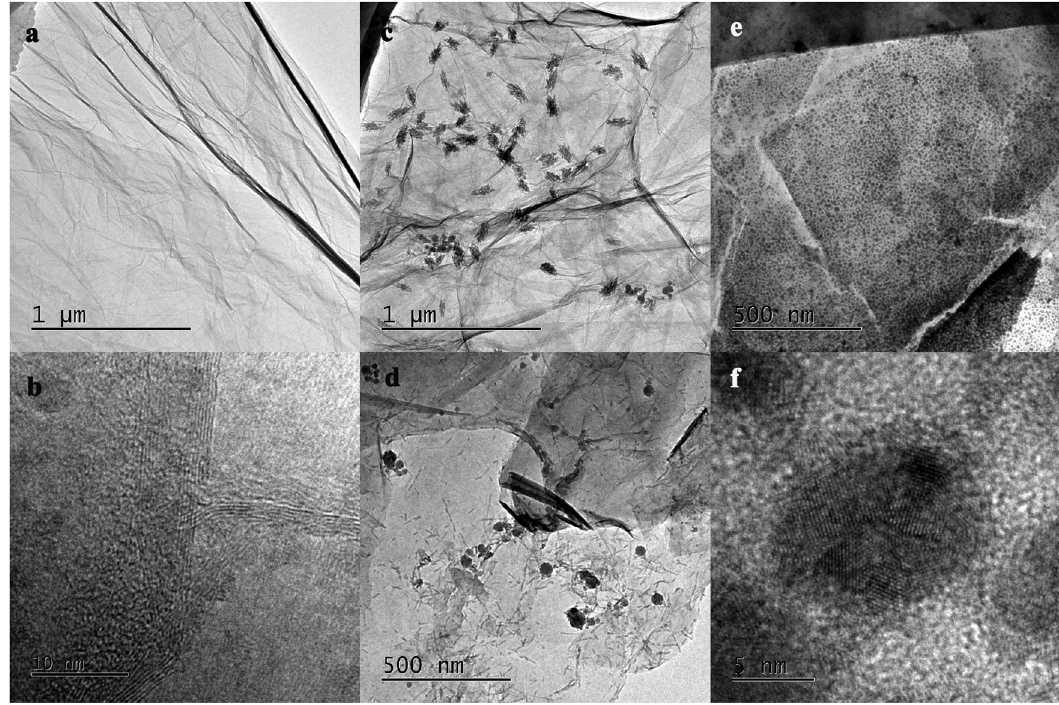
Figure 5: Micromorphology of GO before and after grafting: ( a ) GO, ( b ) HRTEM of GO, ( c and d ) grafted GO, ( e ) GO coated with silver particles, and ( f ) HRTEM of silver particles.